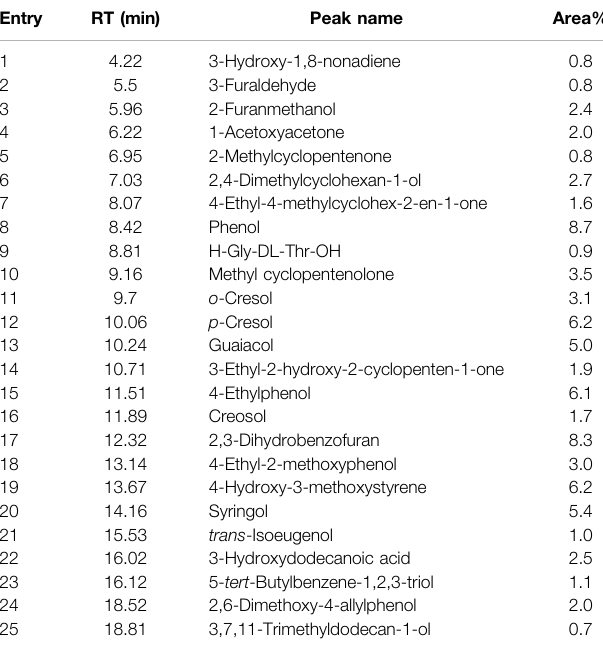
TABLE2| Relativeproportion(area%)ofmostcomponentsofCS-basedbio-oilat 500 ° C. Entry RT (min) Peak name